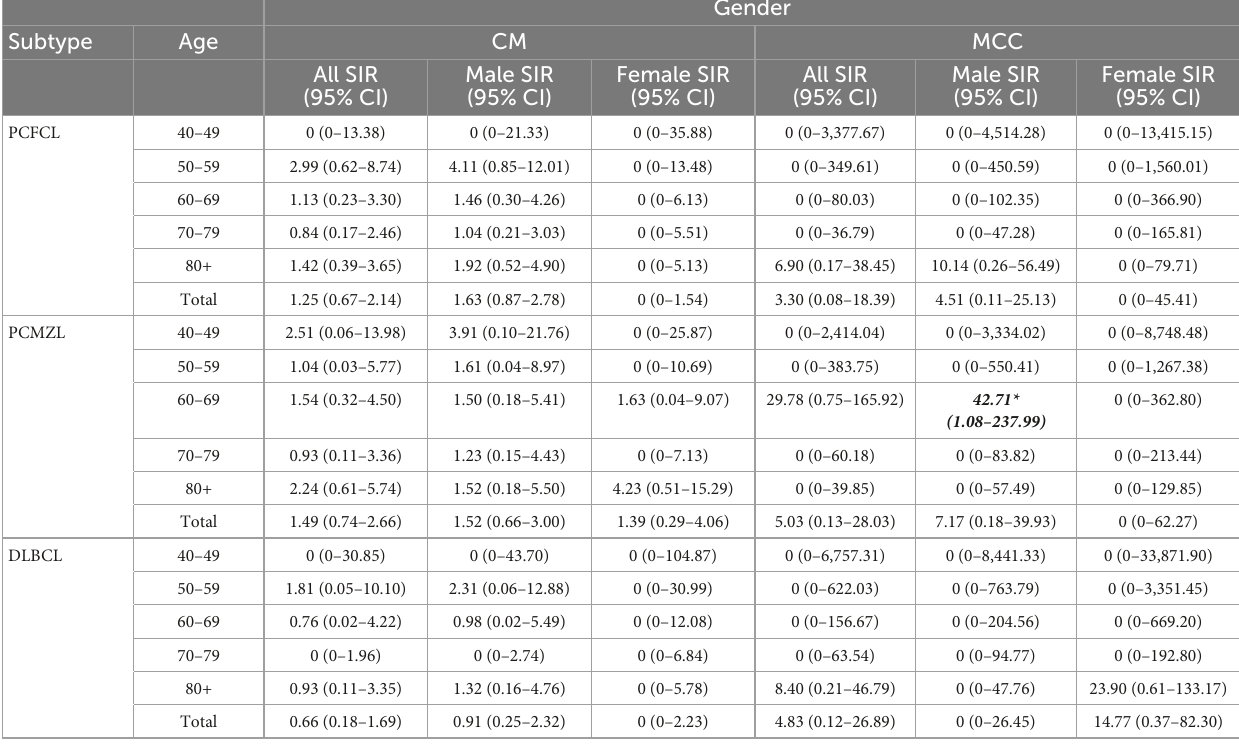
TABLE 4 Incidence of CM and MCC in PCBCL stratified by type, age and